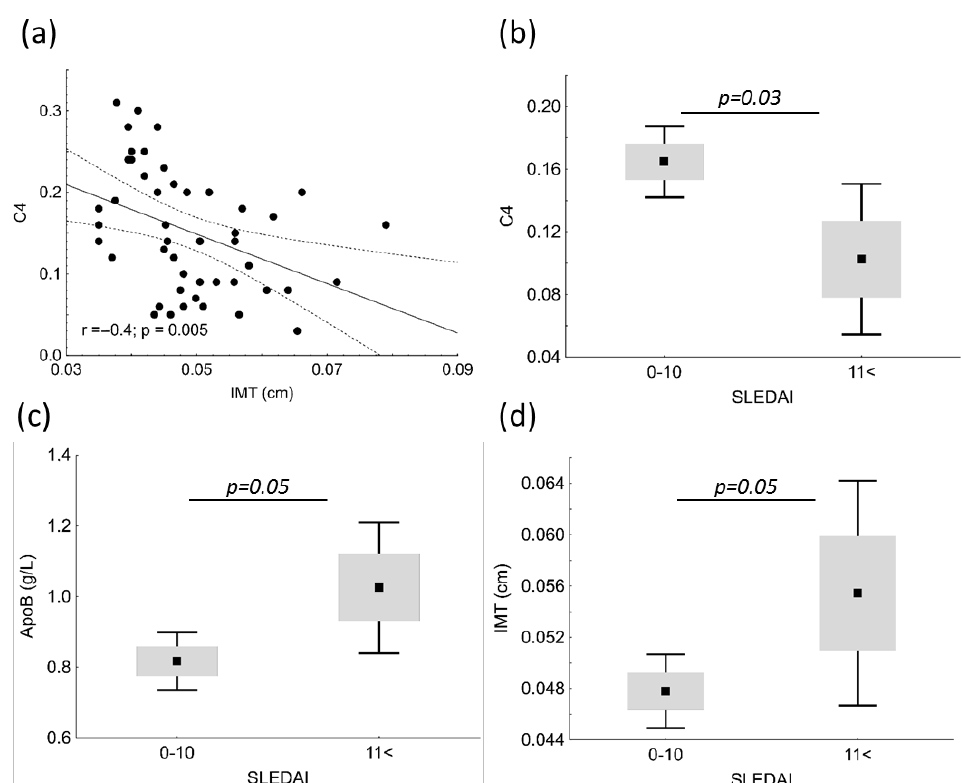
Figure 3. Correlations between complement factor 4 (C4) and carotid intima media thickness (IMT) ( a ) in patients with systemic lupus erythematosus (SLE). C4 ( b ), apolipoprotein B (ApoB) ( c ) and IMT ( d ) in patients with mild/moderate SLE disease activity (SLEDAI = 0–10) and with high/very high SLEDAI (SLEDAI < 11).